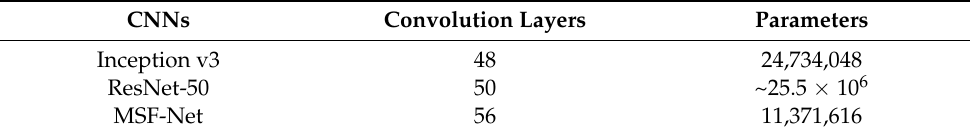
Table 6. Comparison of the number of convolutional layers and parameters of three CNNs.